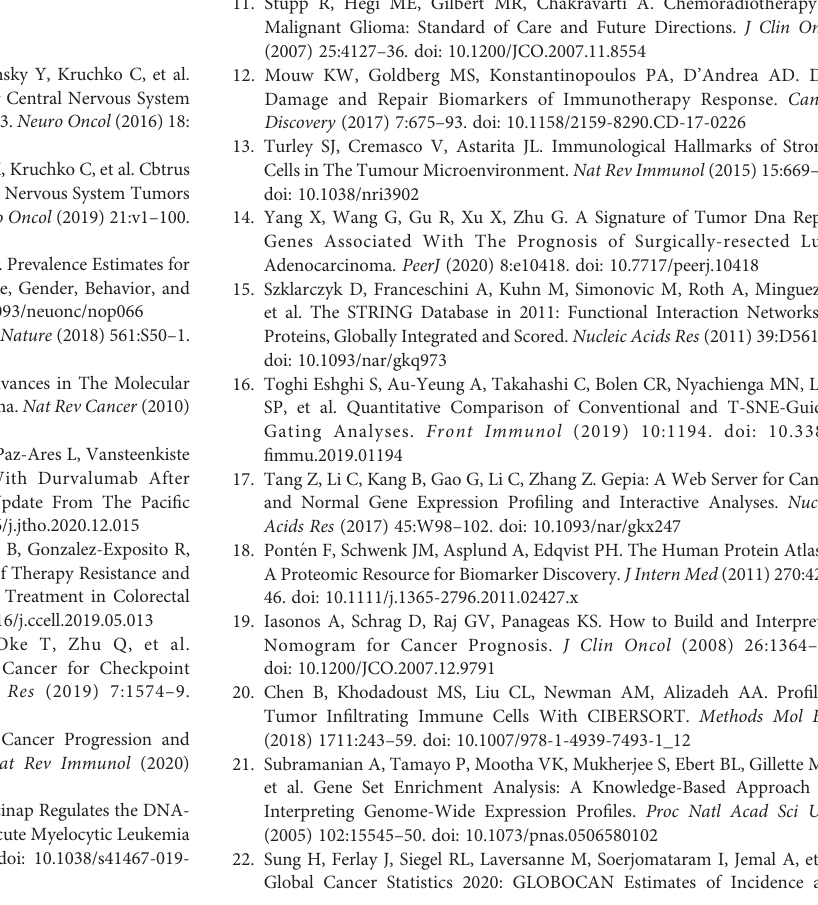
Supplementary Figure 1 | Metascape dataset showing the interaction and enrichment pathways of candidate genes. Supplementary Figure 2 | The gene expression of the constructed risk model and its prognostic impact on glioma patients were analyzed through the GEPIA Supplementary Figure 3 | Proteinexpressionofthegenesusedfortheconstruction ofrisk models by the HumanProtein Atlas. A-E: immunohistochemical assayin normal and tumor tissue ofCDK4, HGMB2, WEE1, SMC3, GADD45G, respectively. Supplementary Figure 4 | TCGA testing and CGGA datasets were used to verify the accuracy of the DDRGs signature. (A, B) Scatterplots illustrating the risk scores for patients with glioma in TCGA testing and CGGA datasets. (C, D) The Heatmap illustrating the expression of the fi ve genes in the high- and low-risk groups. TCGA, The Cancer Genome Atlas; CGGA, Chinese Glioma Genome Atlas; DDRGs, DNA damage repair genes.